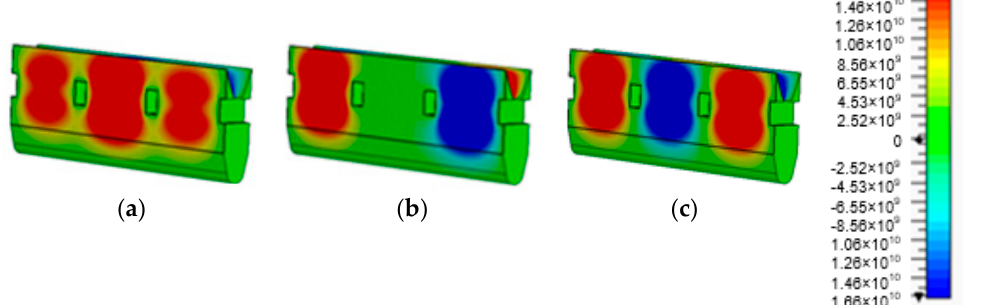
Figure 3. Distribution of electric field along the direction of transmission of MBSC-SWG-SWS. ( a ) Mode 1. ( b ) Mode 2. ( c ) Mode 3.